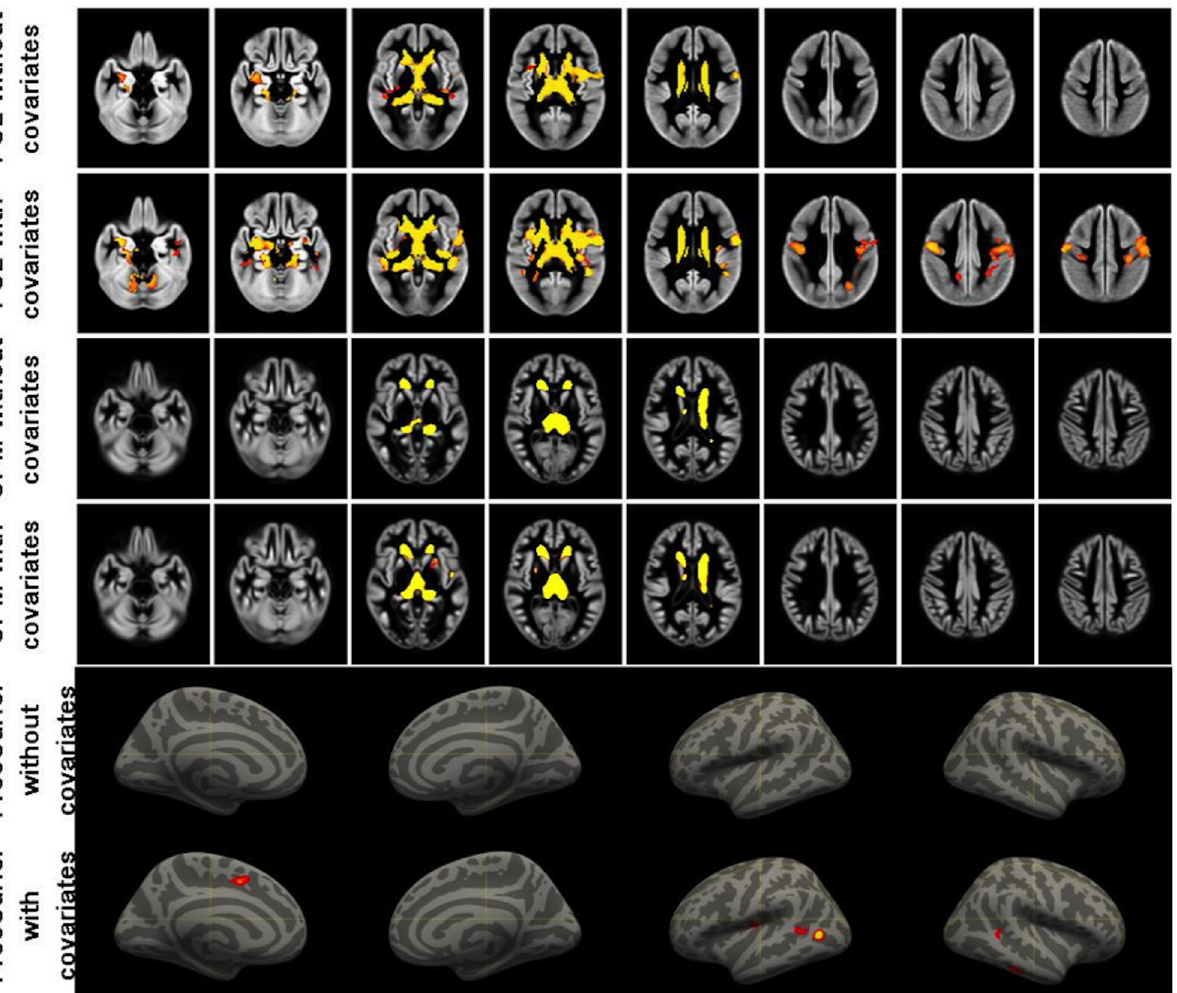
Fig 5. Results of FSL-VBM, SPM-VBM and vertex-wise FreeSurfer, both with and without covariates. The software package and covariate choice is indicated on the left side of the image. The covariates are age and gender. The order of the FreeSufer images is left hemisphere medial side, right hemisphere medial side, left hemisphere lateral side, right hemisphere lateral